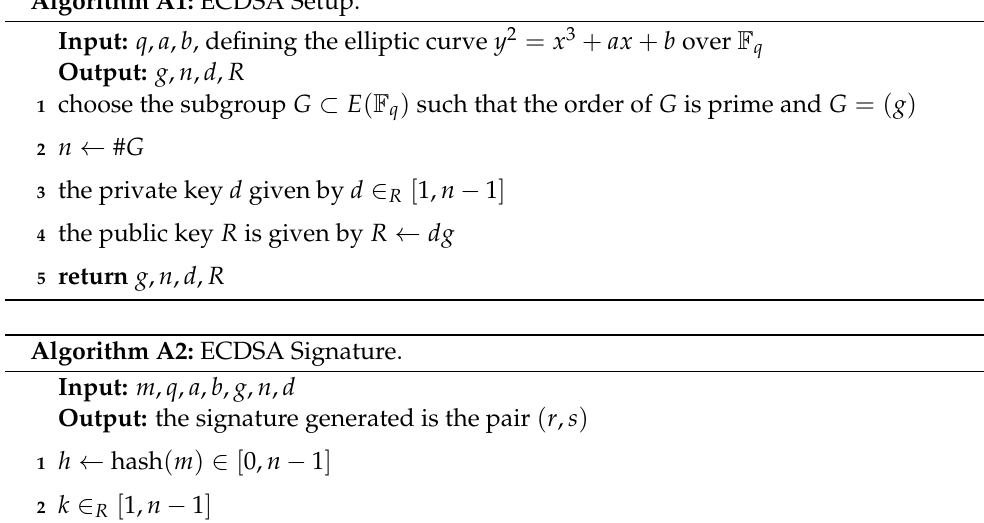
Algorithm A1: ECDSA Setup.